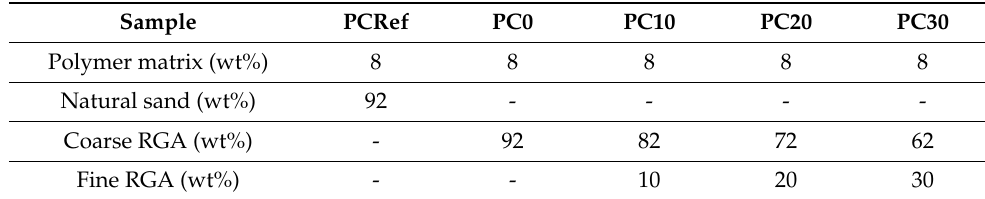
Table 1. Composition of the PCs under investigation. Sample